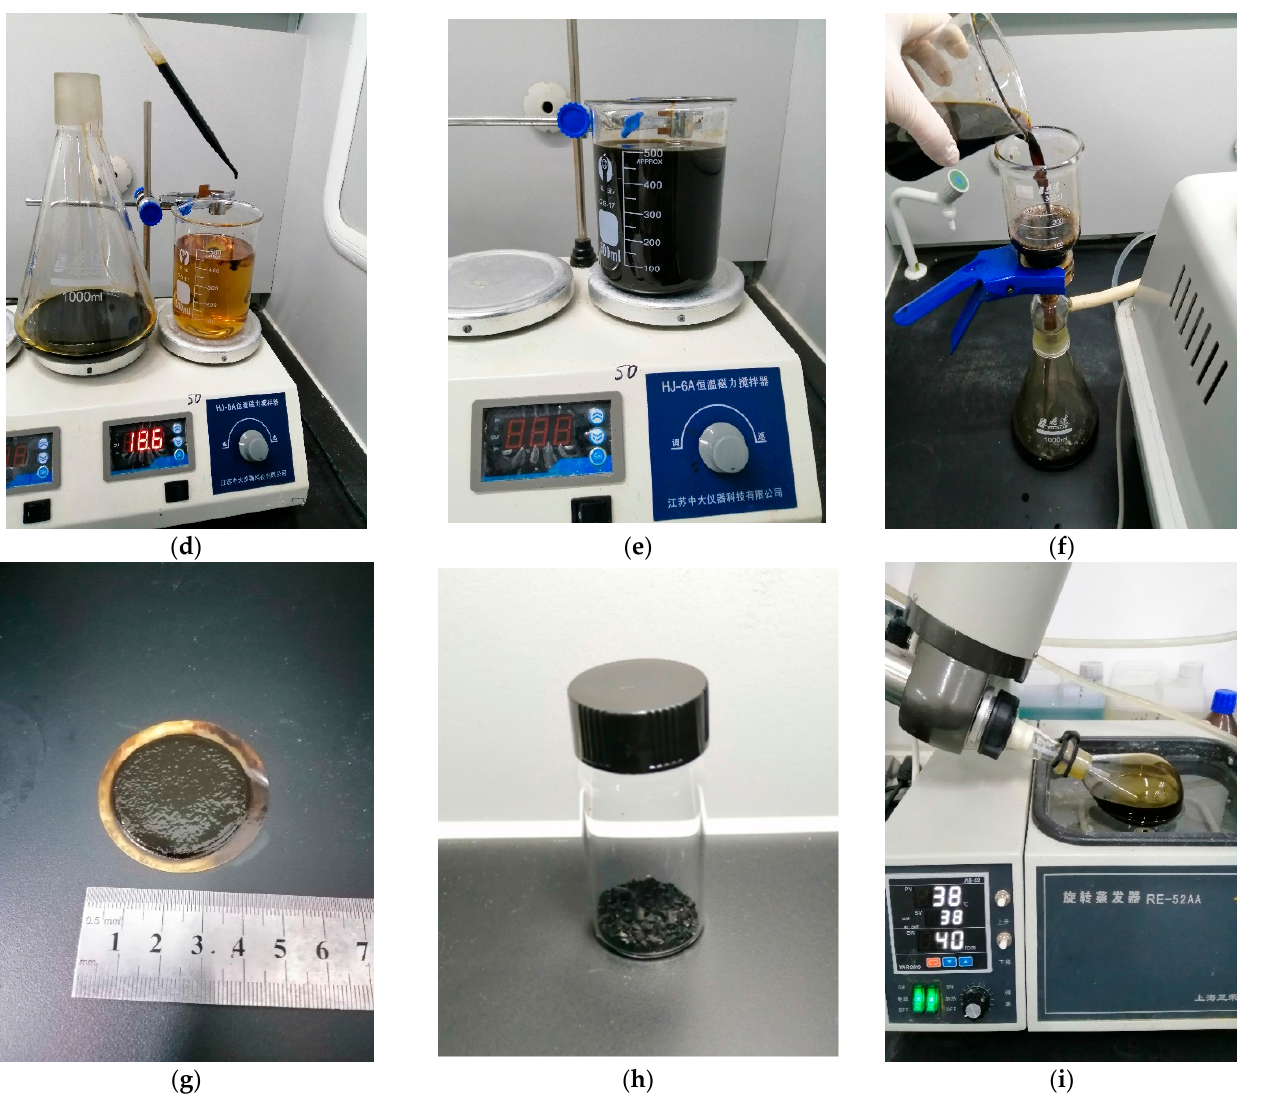
Figure 2. Extraction of asphaltenes from bitumen at room temperature: ( a ) 5 g of asphalt in a 200 mL round-bottomed flask; ( b ) asphalt dissolved in xylene on a thermostatic magnetic stirrer; ( c ) the solution after stirring was filtered to get filter cake 1 and filterate 1; ( d ) the filtrate 1 dropped into the beaker with 450 mL of n-heptane; ( e ) after dropping, the solution in the beaker was left to stand for 30 min; ( f ) the solution in the beaker was filtered to get filter cake 2 and filtrate 2; ( g ) the filter cake 2 after filtering and washing; ( h ) the asphaltene after drying was sealed in a 20 mL glass bottle; ( i ) the solvents in filtrate 2 were recovered by a reduced pressure rotary evaporation.